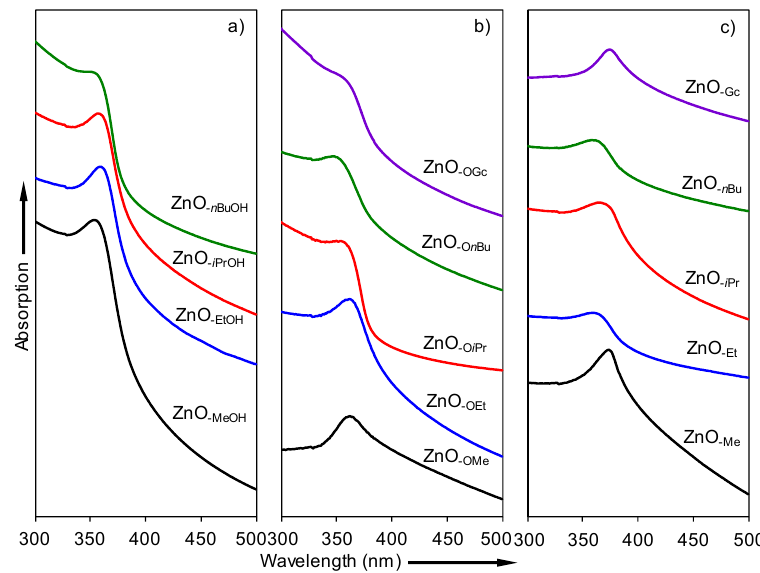
Figure 11. Size-dependent UV-Vis absorption spectra of ( a ) ZnO -ROH ; ( b ) ZnO -OR ; and ( c ) ZnO -R (R = Me, Et, i Pr, n Bu and Gc) NPs.